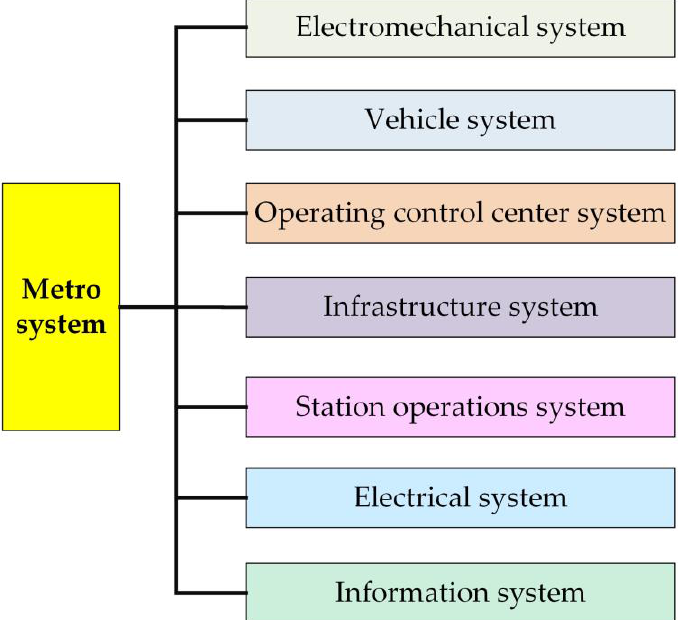
Figure 1. Schematic diagram of seven important systems of a metro company.